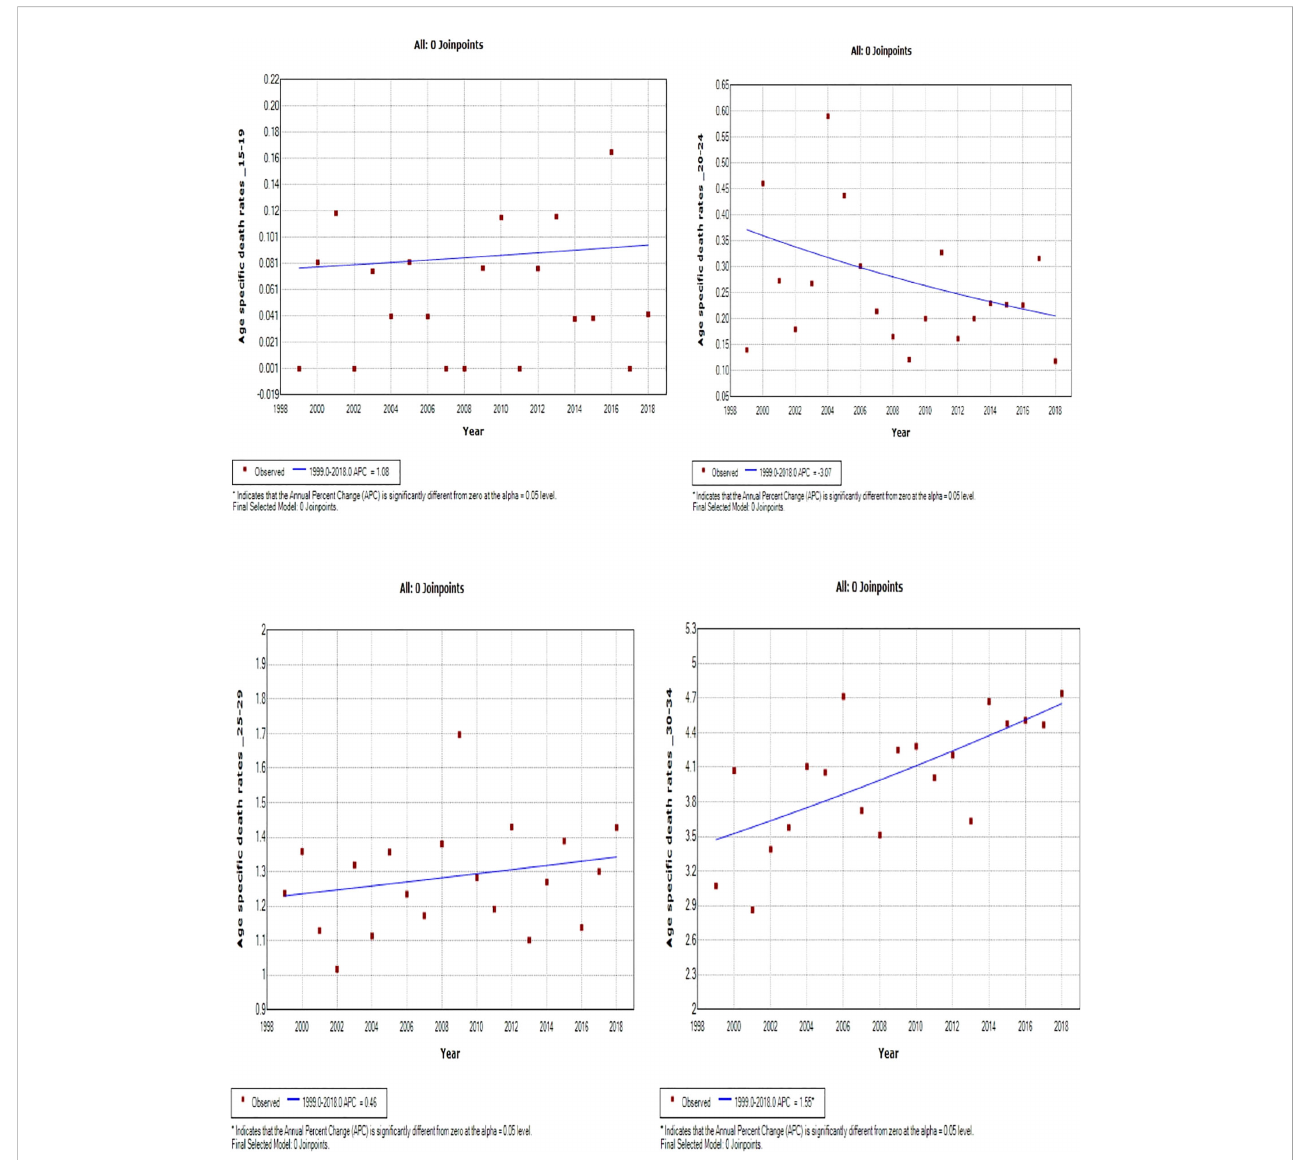
FIGURE 6 Joinpoint trends of age-speci fi c death rates of breast cancer in South Africa. 1999 – 2018, among 19 – 34-year-old (5-year